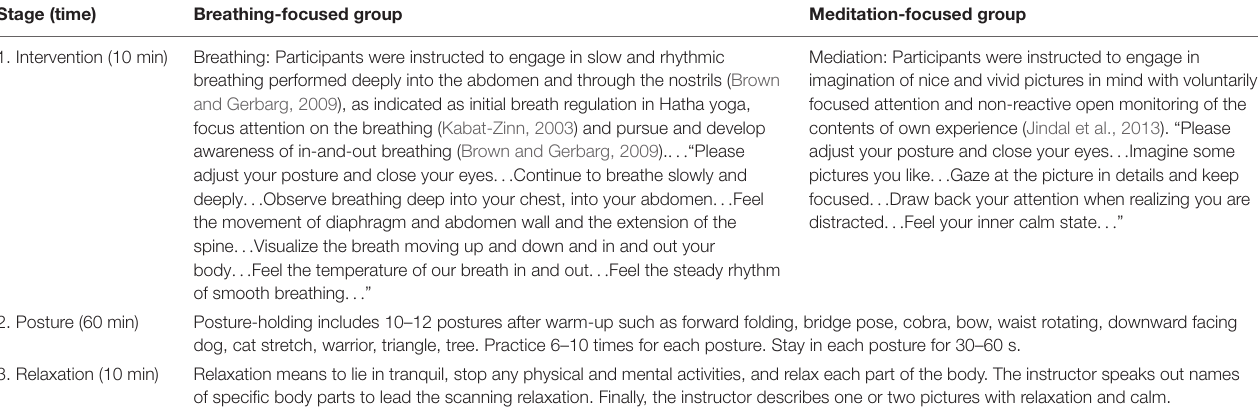
TABLE 1 | Hatha Yoga intervention program. Stage (time) Breathing-focused group Meditation-focused